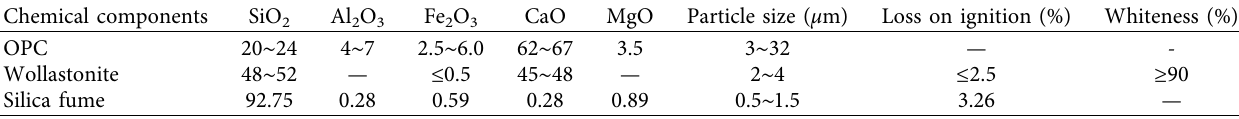
Table 1: Chemical components of OPC, wollastonite, and silica fume.